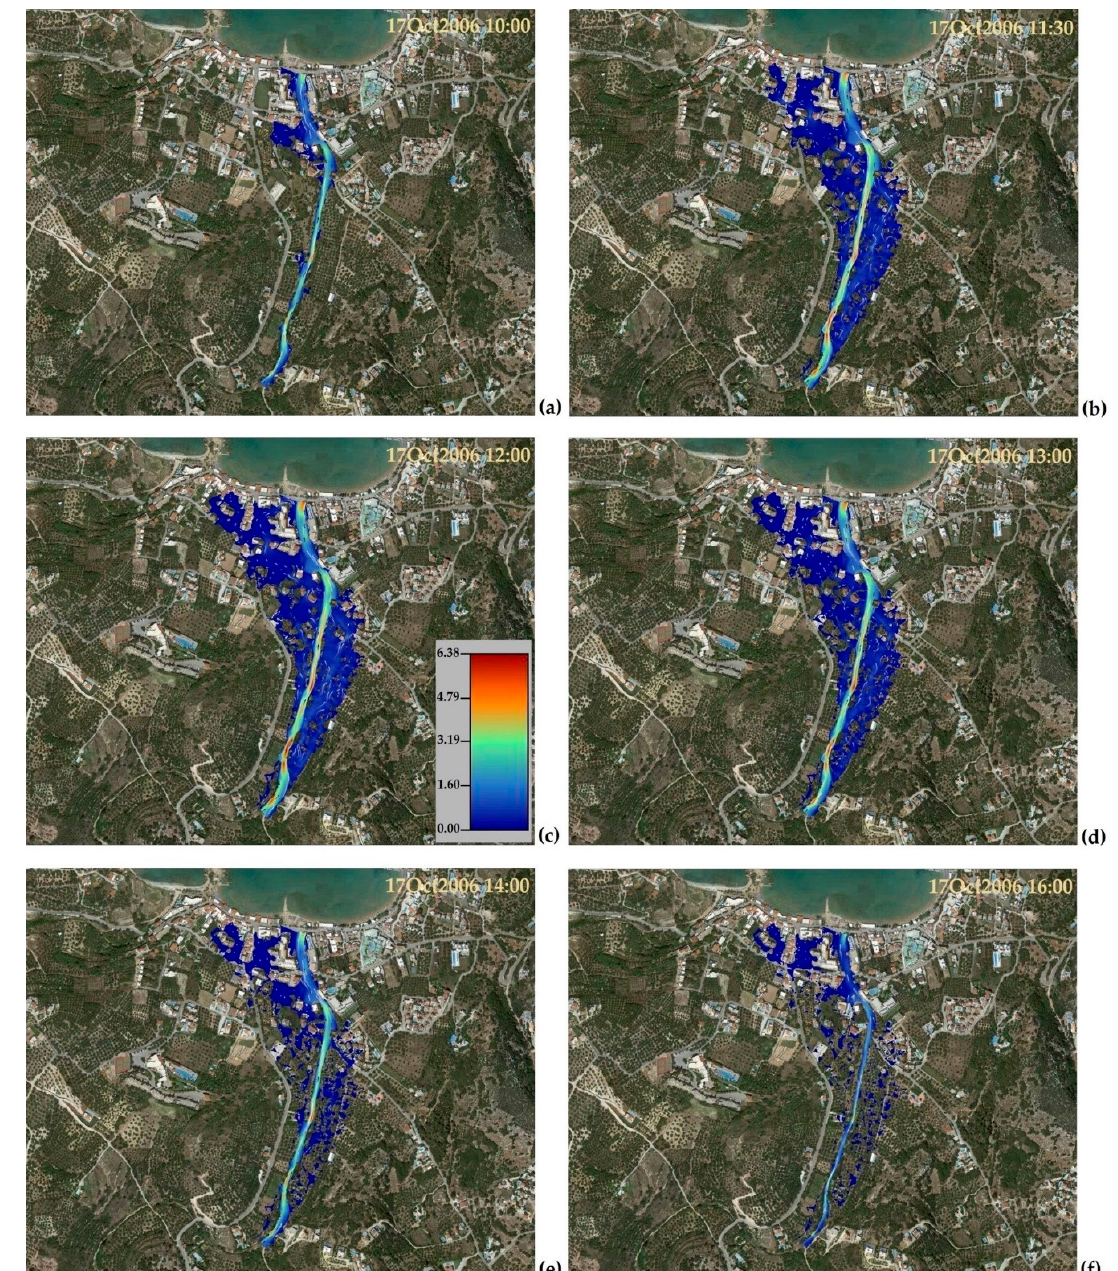
Figure 9. Modeled velocities (m/s) at ( a ) 10:00, ( b ) 11:30, ( c ) 12:00, ( d ) 13:00, ( e ) 14:00, and ( f ) 16:00 of 17 October 2006, by using the coupled 1D/2D HEC-RAS model, at high resolution DEM 2 m × 2 m. In Figure 10, the maximum flood depth as well as the flood inundation extent after 0, 2, 3.5, 4, 5, 6, 8, and 10 h from the beginning of the simulation are presented, for both high-resolution DEMs (5 and 2 m) and a total modeling duration equal to 10 h. The modeled flooded area was calculated through ArcGIS tools. The maximum flood depth was greater when using the DEM at regional analysis 2 m in relation, with the DEM 5 m × 5 m, at all times from the simulation start. Specifically, the maximum flood level was higher at a range from 18.01% to 31.52%, reaching an average raise of 24.91%. On the other hand, the flooded area was notably greater when modeling via the terrain attributed by the DEM at spatial resolution 5 m, compared with the DEM 2 m × 2 m, throughout the modeling duration. The variations ranged from 32.95% to 64.89%, reaching an average increase equal to 46.35%.